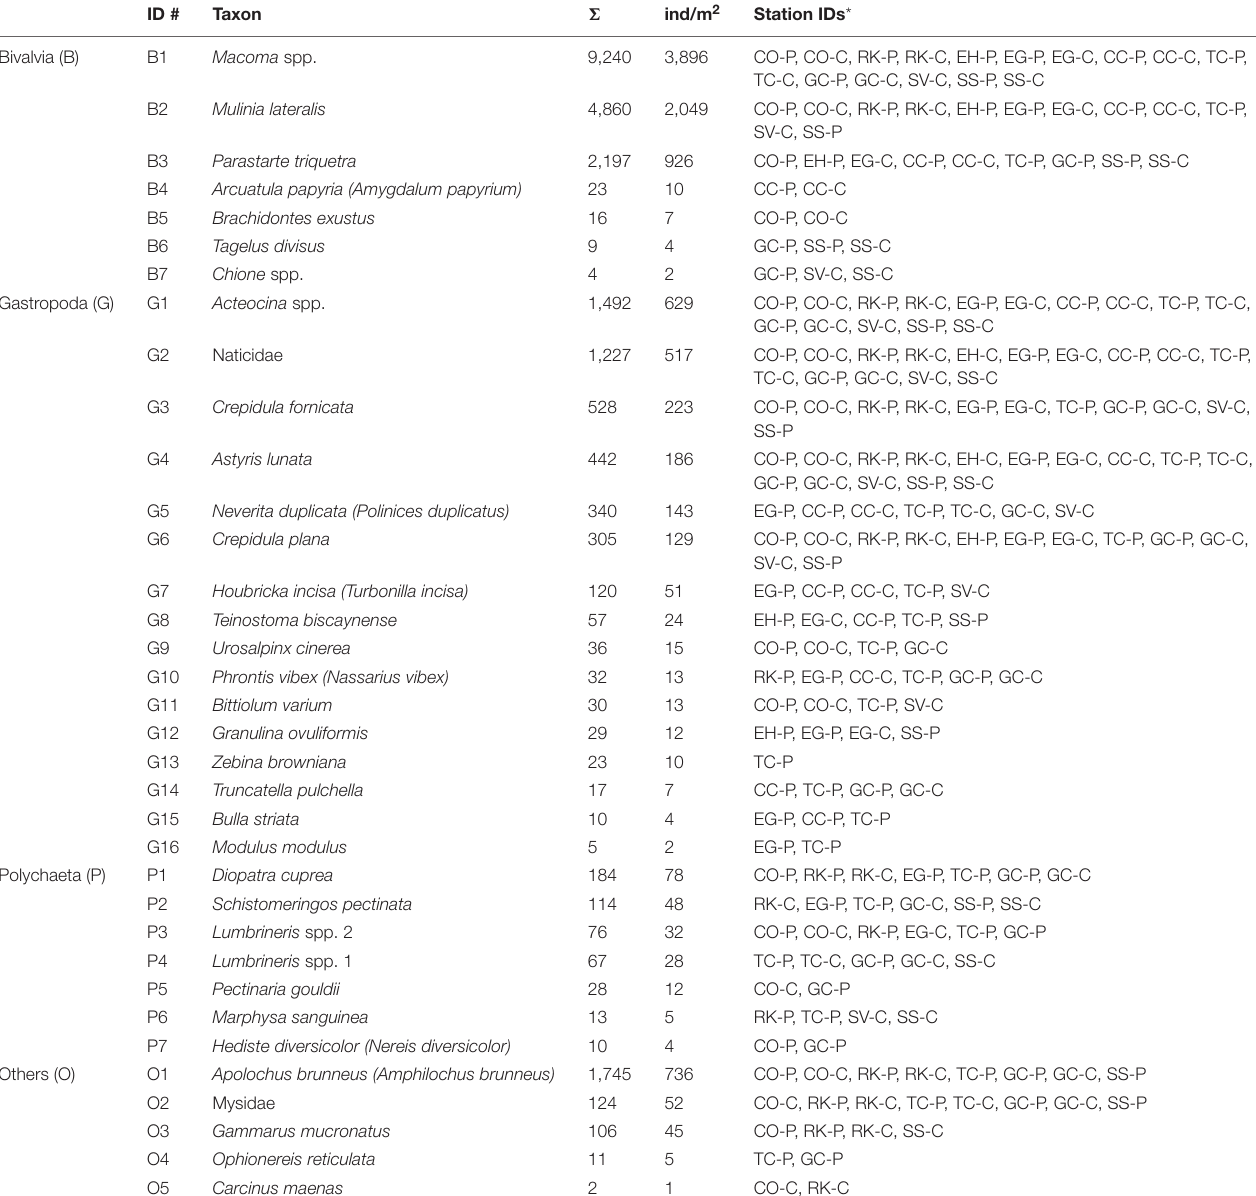
TABLE 2 | Scientific names of organisms collected from Indian River Lagoon, Florida, with identification number (ID), total number of organisms ( (cid:54) ) from 102 grabs (34 stations × 3 grabs/station × 0.023m 2 ), average abundance per grab as individuals (ind) per m 2 and station IDs where each organism was found (P = perimeter, C =